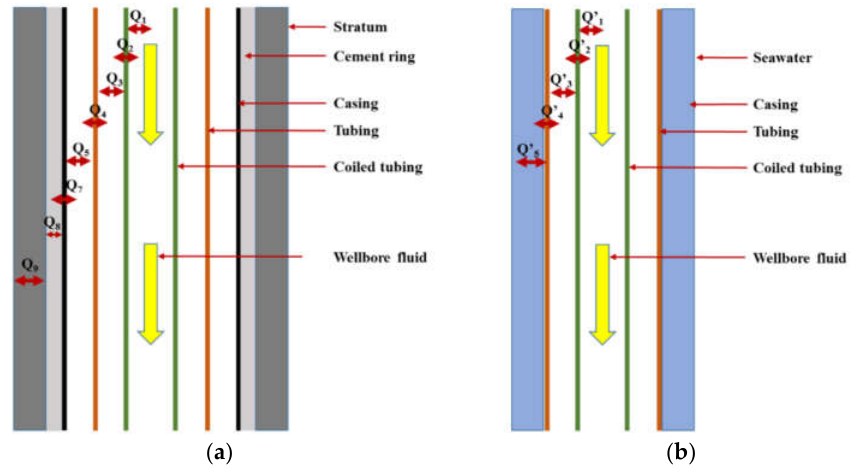
Figure 2. Schematic diagram of wellbore heat transfer. ( a ) Below the mud line. ( b ) Above the mud line.